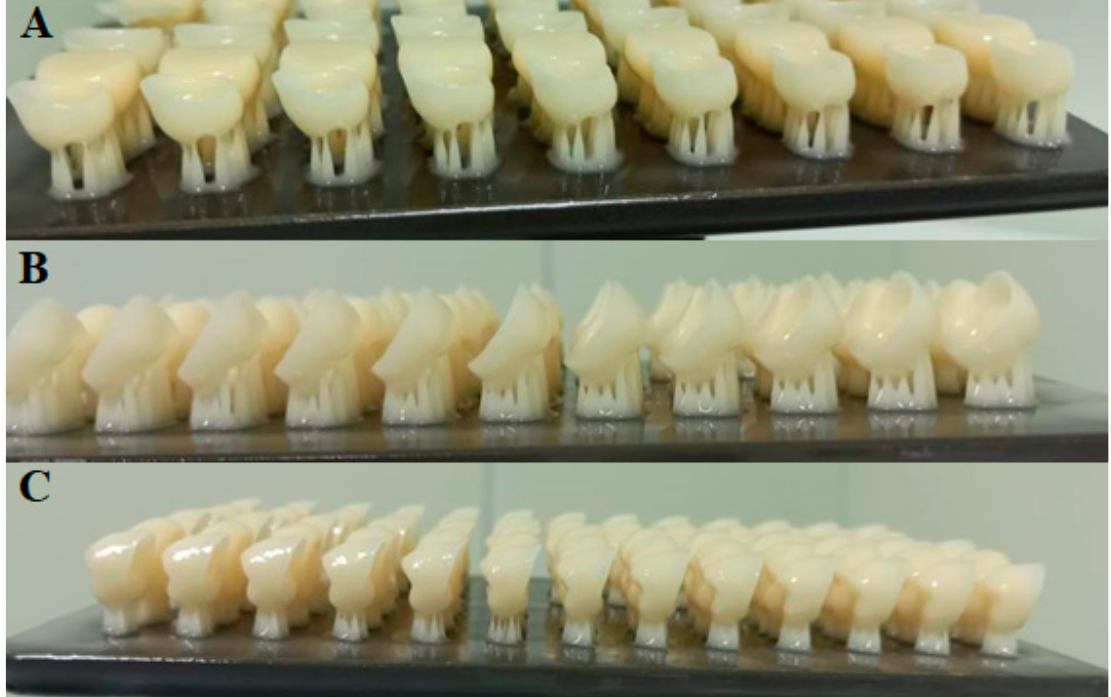
Figure 5. The 3D-printed specimens with di ff erent orientations for ASIGA. ( A ) 0-degree, ( B ) 45-degree, and ( C ) 90-degree (scale bar 5 mm).